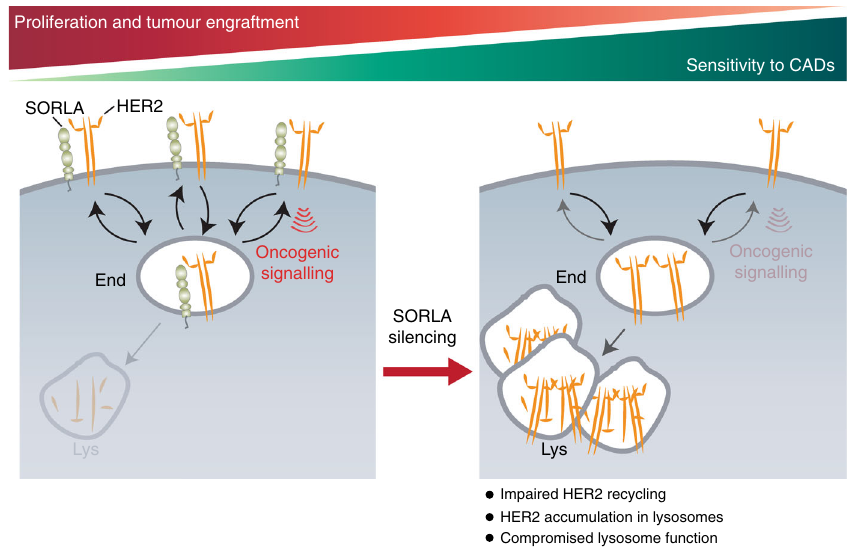
Fig. 7 Schematic illustrating the role of SORLA in the oncogenic fi tness of HER2 in cancer cells. SORLA, through interactions at its extracellular domain, is in a complex with HER2 and co-traf fi cs with HER2, facilitating HER2 recycling to the plasma membrane to support HER2 downstream signalling. In the absence of SORLA, HER2 becomes localized to enlarged, partially dysfunctional lysosomes resulting in defective HER2 signalling and increased sensitivity to cationic amphiphilic drugs (CADs) like ebastine. End endosome, Lys